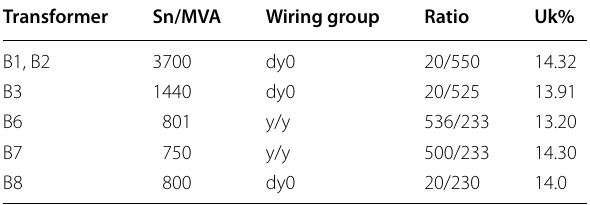
Table 3 Main parameters of the transformers